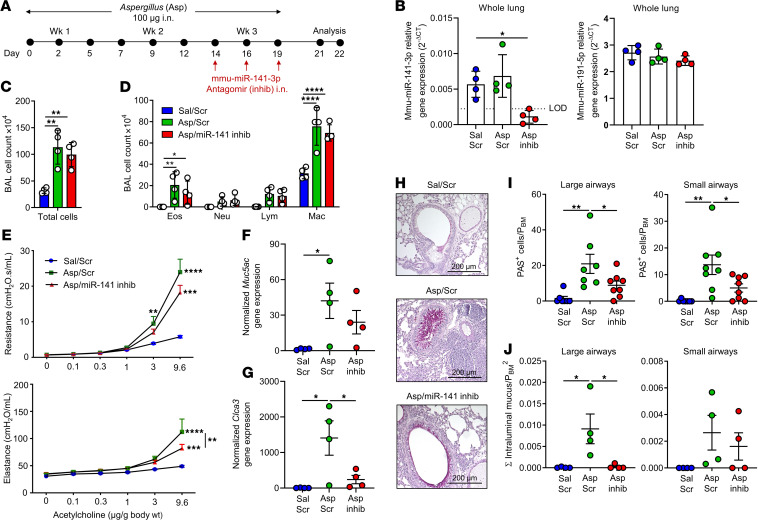
Blockade of mmu-miR-141-3p improves airway hyperresponsiveness and decreases secreted mucus in an experimental mouse model of asthma.(A) Timeline of allergen-induced model of asthma induced by intranasal (i.n.) exposure to fungal allergen Aspergillus fumigatus (Asp) 3 times per week for 3 weeks; details are provided in the Methods section. (B) Expression level of mmu-miR-141-3p (left) and nontargeting control mmu-miR-191-5p (right) in whole lung tissue by TaqMan qPCR normalized to reference miRNA mmu-miR-103-3p (n = 4, 1-way ANOVA followed by Tukey test; *P < 0.05). (C and D) Total cells (C) and cellular distribution (D) in bronchoalveolar lavage (BAL) obtained from mice exposed to Asp in combination with mmu-miR-141-3p antagomir (Asp/miR-141 inhib), Asp in combination with scrambled antagomir (Asp/Scr), and sterile saline in combination with Scr antagomir (Sal/Scr) (n = 7-8/group, 1-way (C) or 2-way (D) ANOVA followed by Tukey test; *P < 0.05, **P < 0.01, ****P < 0.0001). Eos, eosinophils; Neu, neutrophils; Lym, lymphocytes; Mac, macrophages. (E) Total respiratory system resistance and elastance measured in mice exposed to Asp/miR-141 inhib, Asp/Scr, and Sal/Scr (n = 7–8/group, repeated measures 2-way ANOVA followed by Bonferroni correction; **P < 0.01, ***P < 0.001, ****P < 0.0001). (F and G) Gene expression of Muc5ac (F) and Clca1 (G) assessed by qPCR analysis of lung tissue homogenate 72 hours after the final allergen challenge (n = 4/group, 1-way ANOVA followed by the Tukey test; *P < 0.05). (H) Representative Alcian Blue–Periodic Acid Schiff–stained (AB-PAS–stained) lung sections from Asp/miR-141 inhib, Asp/Scr, and Sal/Scr mice (representative of 4 mice). (I and J) Quantification of PAS+ cells per perimeter of basal membrane (I) and intraluminal mucus per basal membrane area (J) in large (>0.80 mm) and small (<0.80 mm) airways (n = 7–8/group, 1-way ANOVA followed by the Tukey test; *P < 0.05, **P < 0.01).